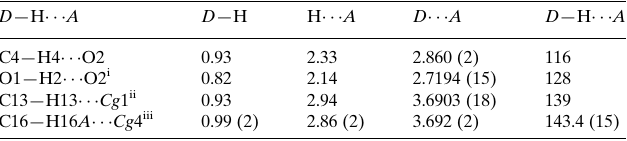
Hydrogen-bond geometry (A˚ , (cid:2) ). Cg 1 and Cg 4 are the centroids of the N1/C8–C11 and C2–C7 rings,